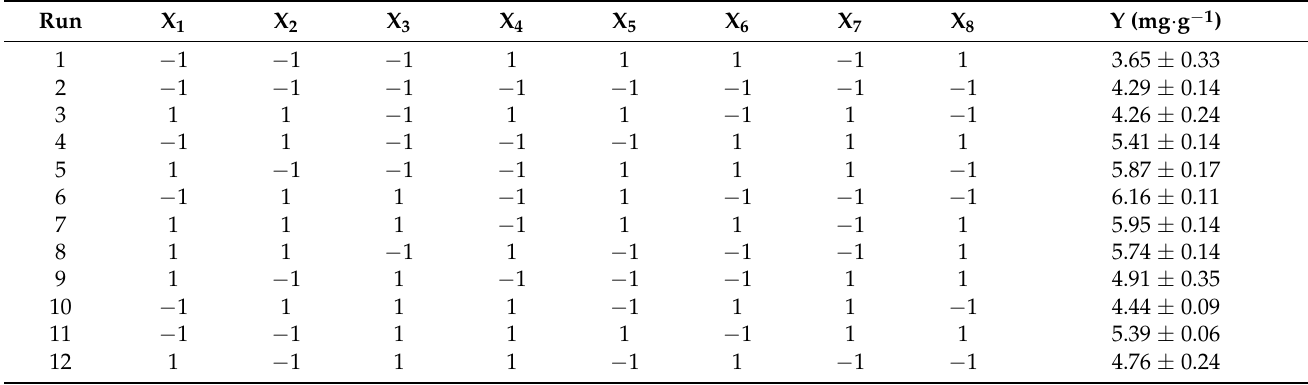
Table 1. Design matrix and results of PBD